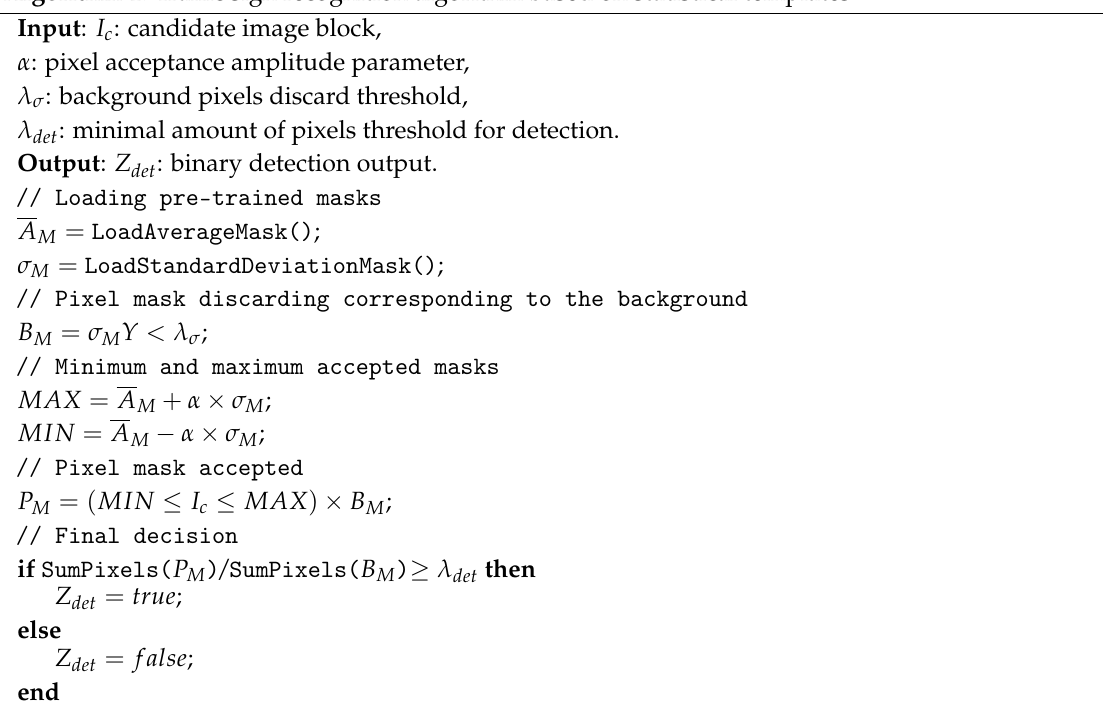
Algorithm 1 : Traffic sign recognition algorithm based on statistical